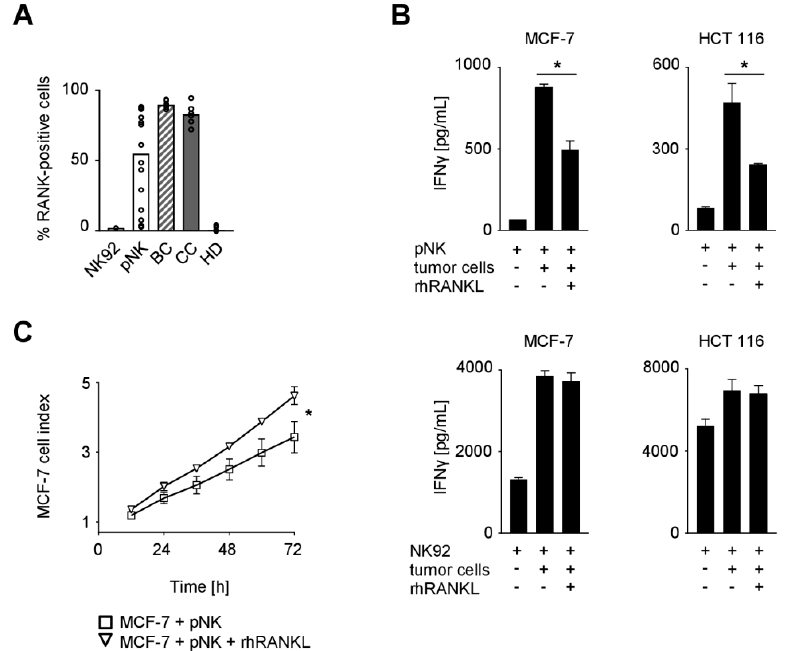
Figure 2. Expression of RANK and functional role of the RANK/RANKL axis in NK cell reactivity against solid tumors. ( A ) RANK surface expression on NK92 cells, pNK cells, and NK cells among PBMC from BC and CC patients and HD was investigated by flow cytometry ( n = 1, 14, 6, 6, and 9, respectively). Median values of the respective group are depicted. ( B ) pNK (upper panel) or NK92 cells (lower panel) were cultured in the presence or absence of the indicated tumor cells and rhRANKL (125 ng/mL). IFN γ levels in culture supernatants were determined by ELISA after 24 h. ( C ) pNK cells were co-cultured with MCF-7 cells in the presence or absence of rhRANKL (125 ng/mL). The effect of NK cell reactivity on tumor cell proliferation/survival was assessed by xCELLigence RTCA for 72 h. Results are shown as electrical impedance signal (given as cell index). ( B , C ) Representative data of one experiment from a total of at least three with similar results are shown. Statistically significantly different results ( p < 0.05) are indicated by *.